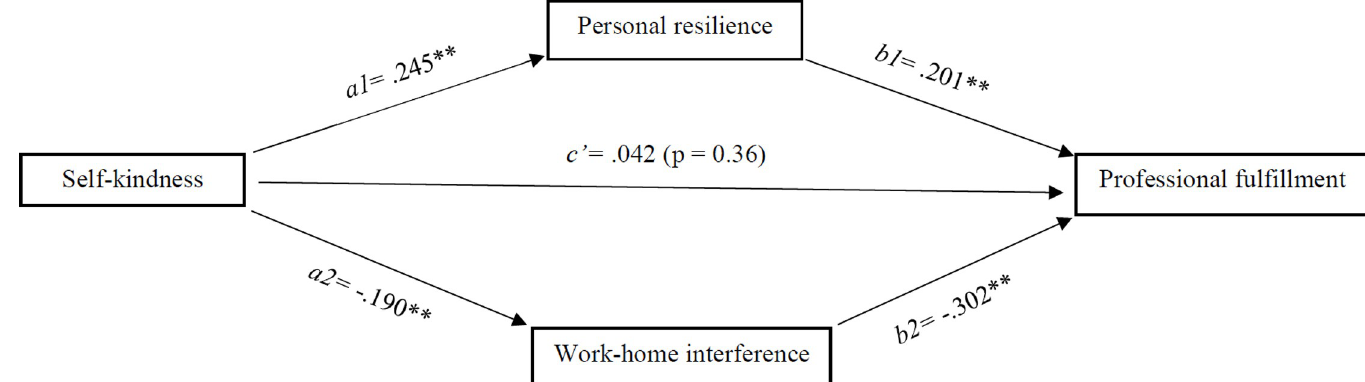
Fig 1. Conceptual model. The model depicts the relationship between self-kindness and professional fulfillment, mediated by personal resilience and work-home interference, found amongst cardiologists in the Netherlands ( n = 374) in 2020. The model was adjusted for sex and years of registration. ** ( p < 0.01).